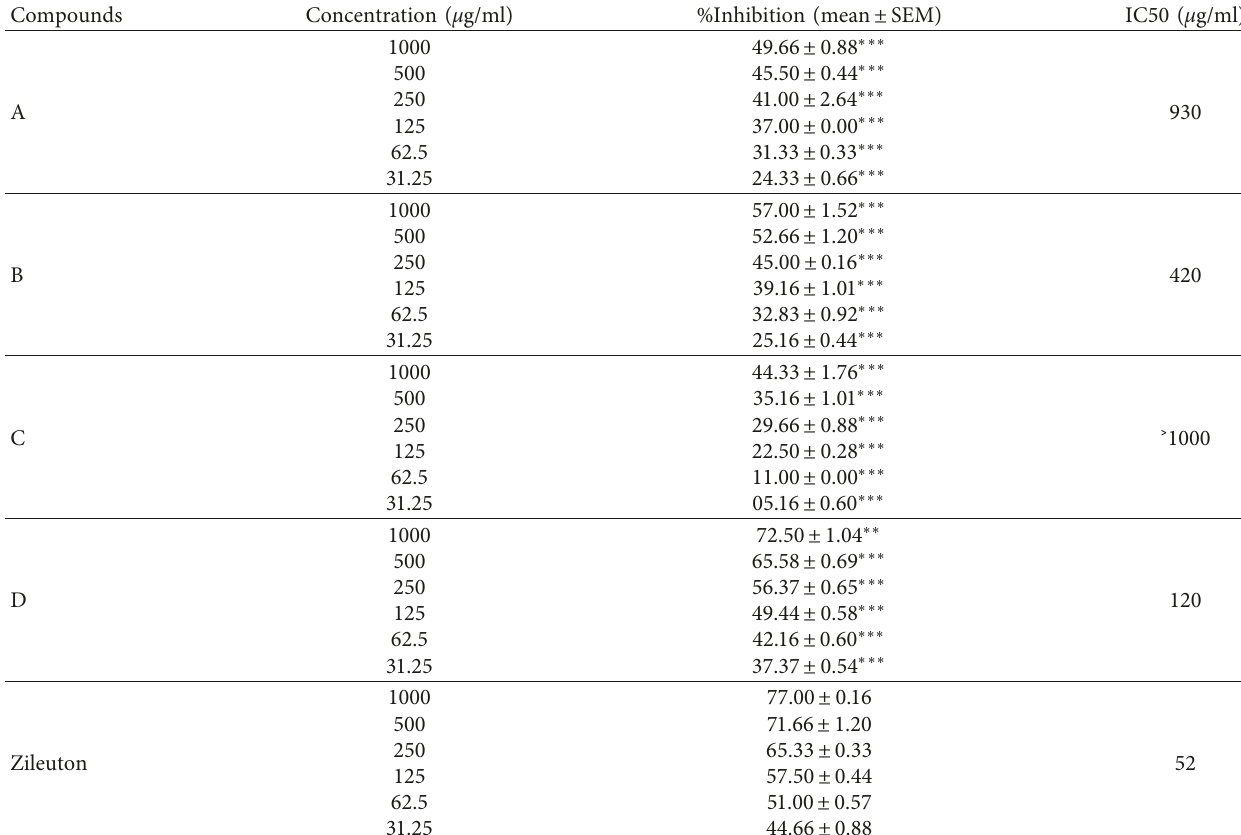
Table 2: 5-LOX inhibitory potentials of the